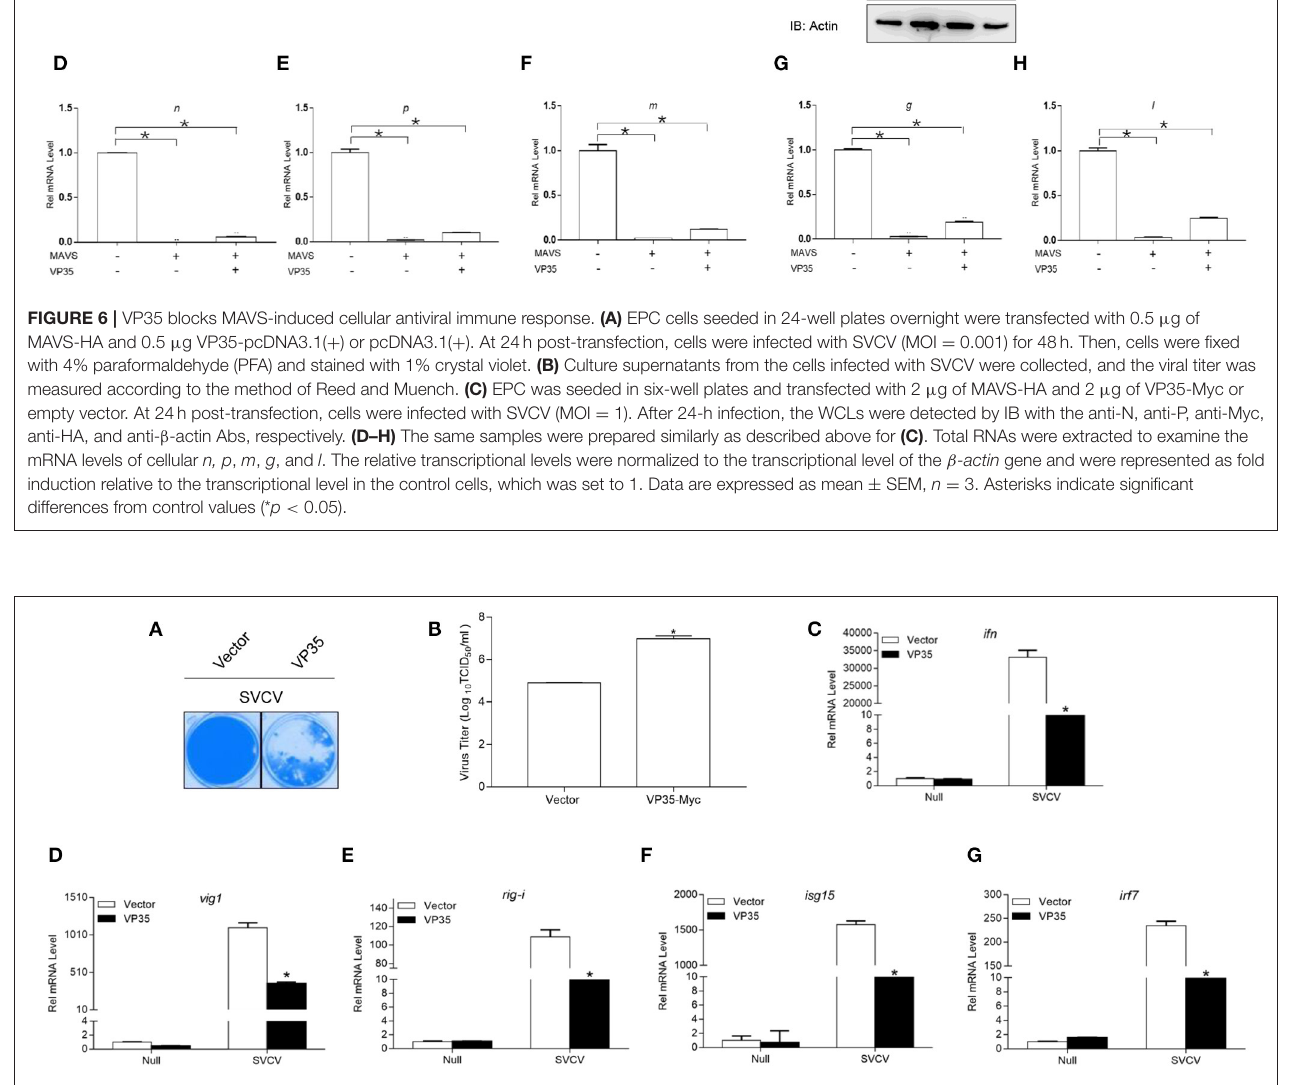
Frontiers in Immunology |